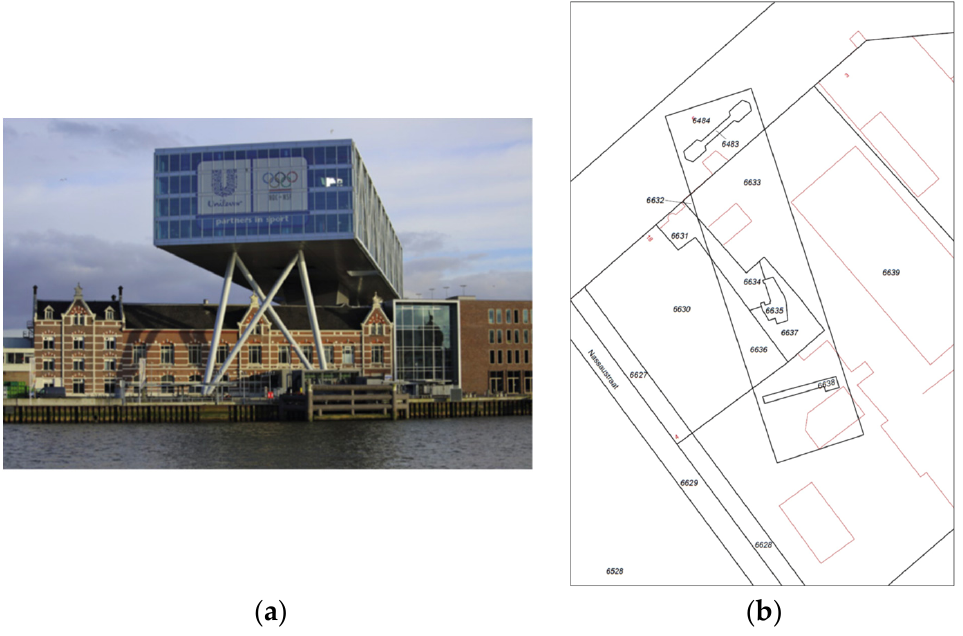
Figure 2. “The Bridge” building in Rotterdam, the Netherlands ( a ), being a separate real property above other properties and roads, shown on the Dutch Cadastral Index Map ( b ) [2]. Photo by F. Schouwenburg (Creative Commons-license).